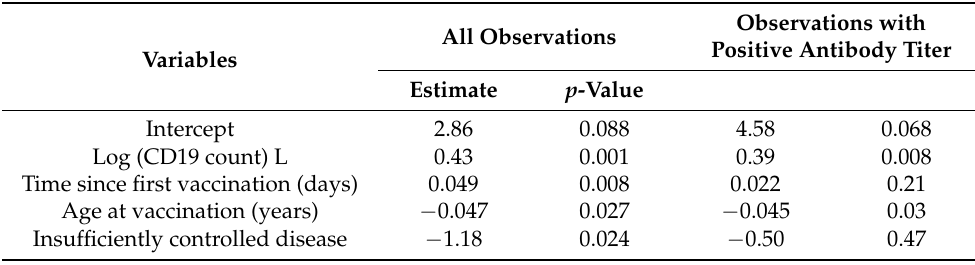
Table 3. Effect of CD19+ B-cell count and other covariables on antibody titer values. Results of linear regression model (§). Observations All Observations Variables